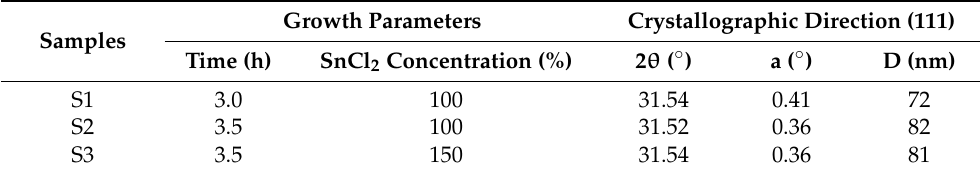
Table 1. SnS thin-film samples conditions prepared by CBD and crystallite estimated size. Growth Samples